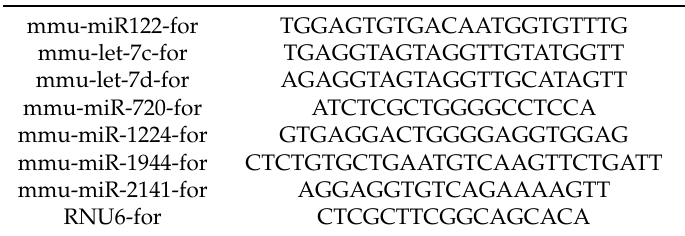
Table 3. Primers for microRNA